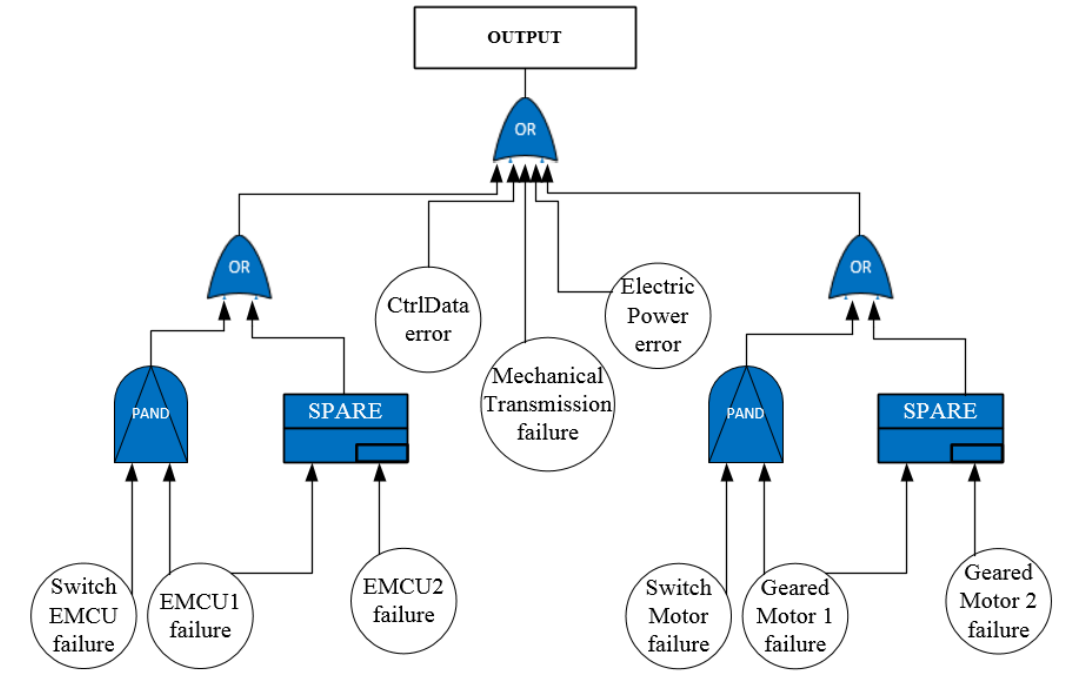
Figure 8. Dynamic Fault Tree (DFT) of the EMA